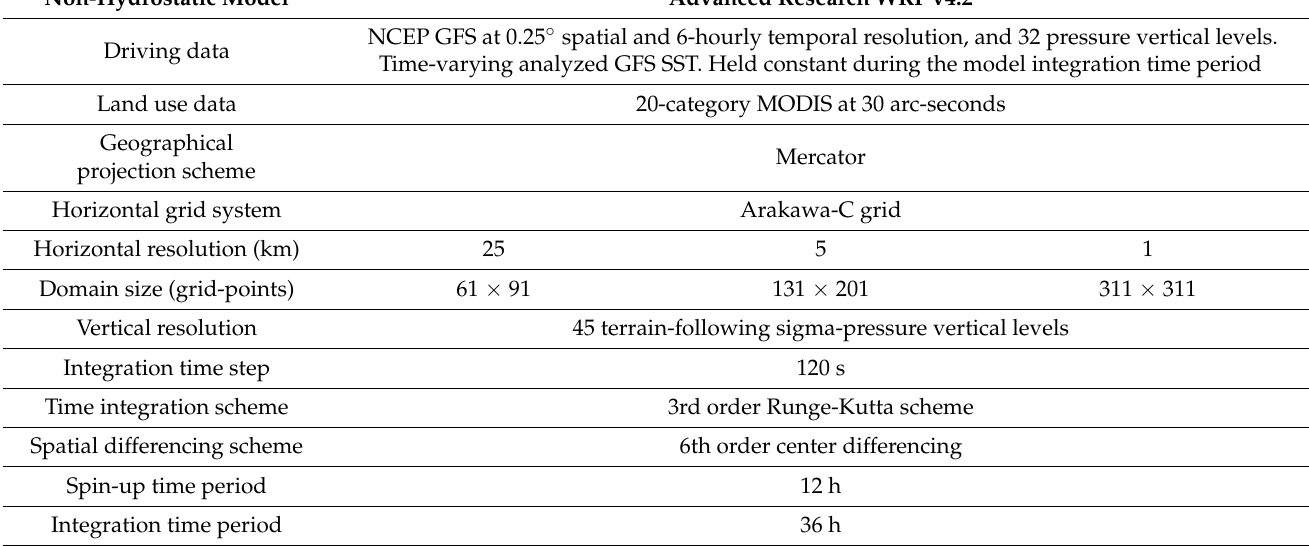
Table 2. WRF model configuration around